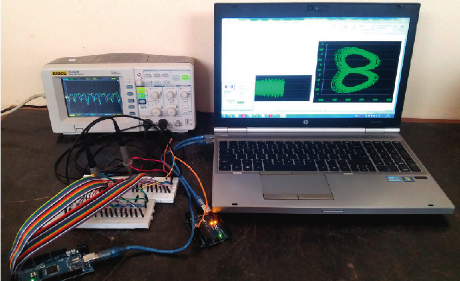
Figure 17: Practical setup for the experiment on the microcontroller-based on the implementation of system